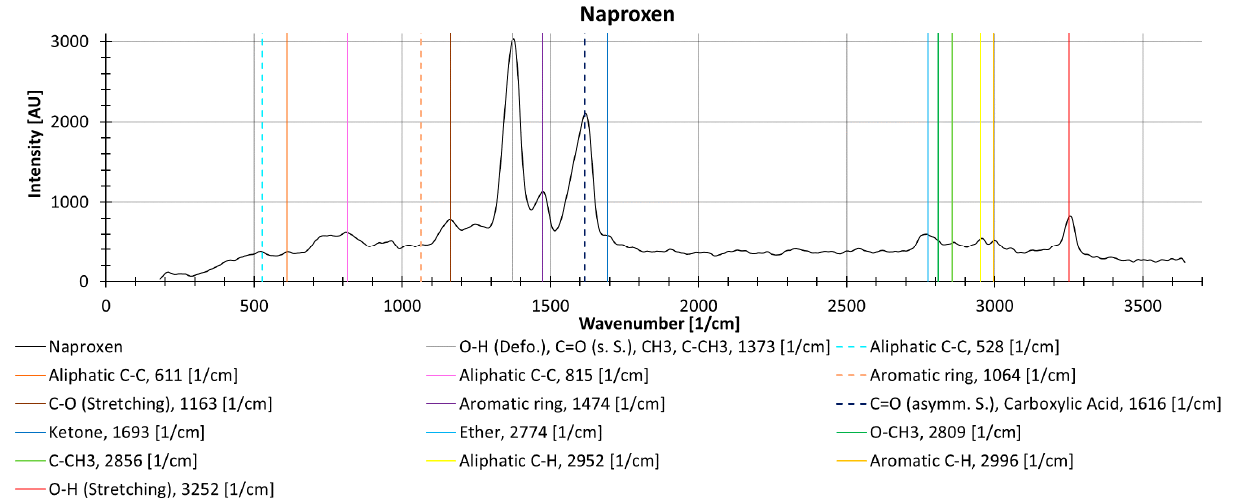
Figure 13. Raman spectrum from naproxen as a solid powder (without cuvette), with information about molecular oscillation and peak identification from the KnowItAll software [47].